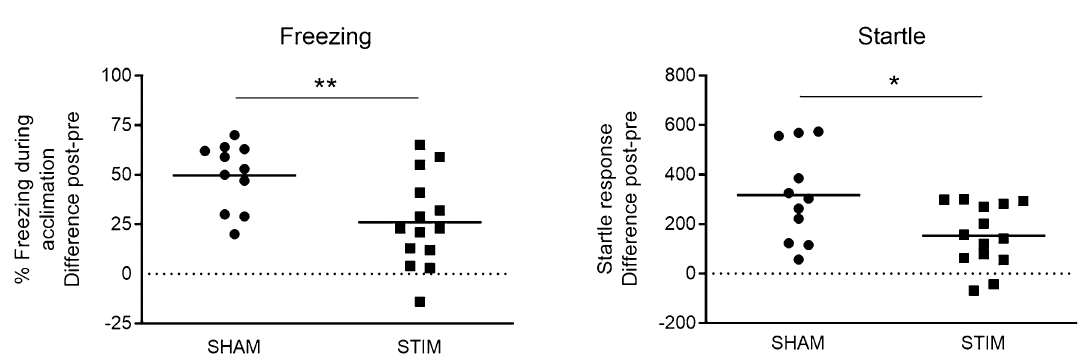
Figure 5. Percentage freezing during acclimation (left panel) and startle response (right panel) in Experiment 2. Difference scores of Post- minus Pre-test are shown as individual data points and means for SHAM (n = 11) and STIM (n = 14) animals, *p < 0.05; **p <